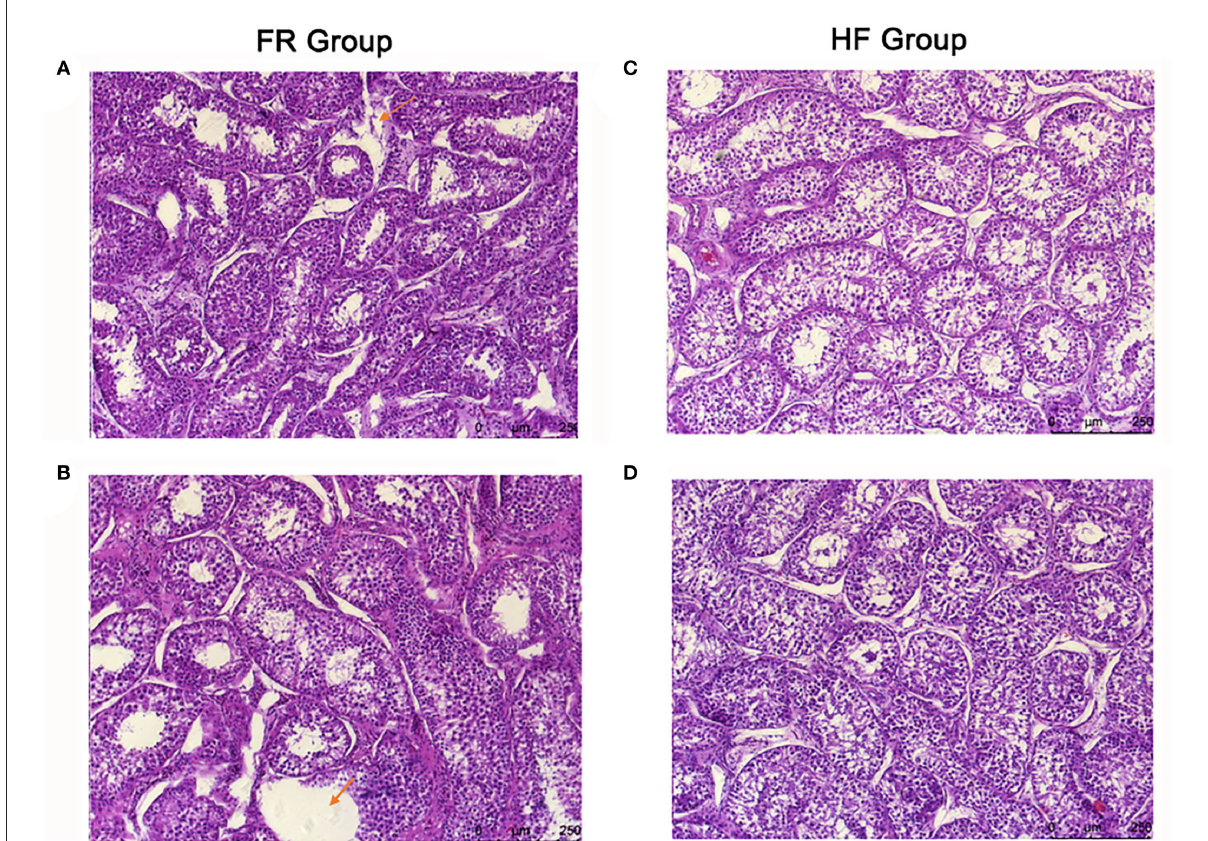
FIGURE2 (A,B) H&E-stained sections of yak testis in free range group under 10x microscope. The arrow in (A) means part of the connective tissue was broken in the FR group. The arrow in (B) means the space between the seminiferous tubules was enlarged, and the seminiferous tubules were also loosely arranged and structurally disordered. (C,D) H&E-stained sections of yak testis in house feeding group under 10x microscope.